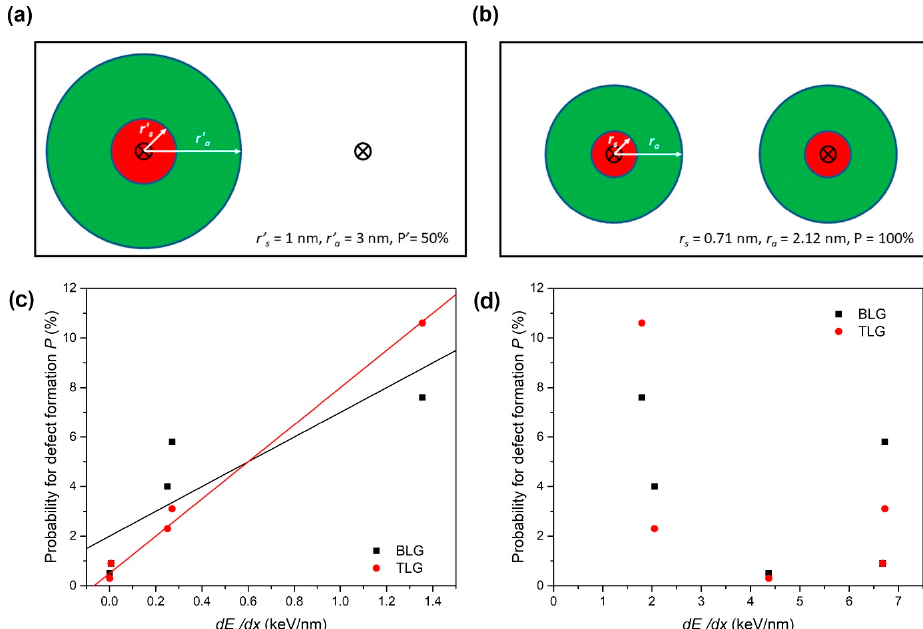
Figure 3. Illustration of the identical Raman response under the assumption of damage probability equal to ( a ) P’ = 50% and ( b ) P = 100% (x marks the ion impact spot). Damage production probability P for BLG and TLG, correlated with ( c ) nuclear energy loss dE n / dx and ( d ) electronic energy loss dE e / dx (calculated by SRIM [30] for the graphite). Table 2. Results of the Raman spectroscopy analysis of irradiated BLG and TLG samples: radius r s of the structurally disordered area due to the ion impact, radius r a of the activated area, their difference r a − r s , and probability P of damage formation due to the ion impact.